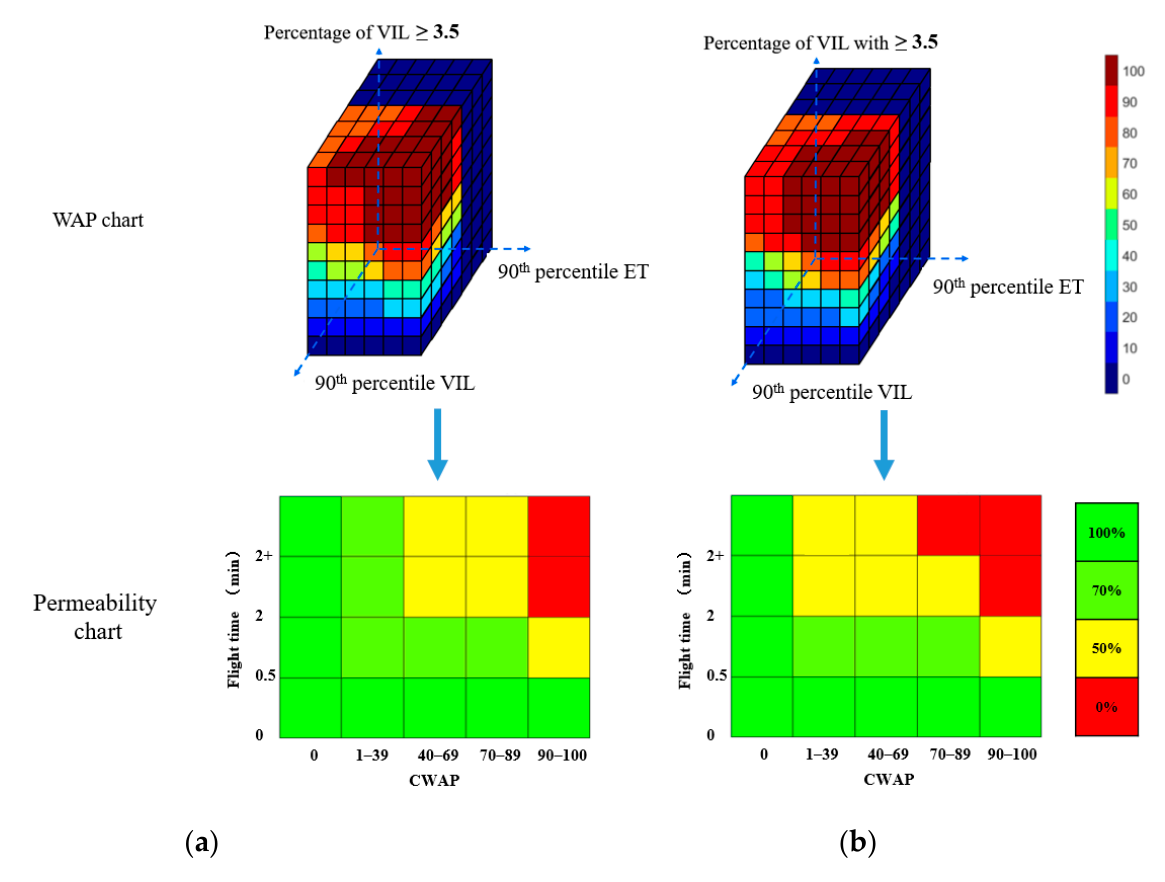
Figure 8. CWAP and permeability charts of the Guangzhou terminal area and Wuhan terminal area. ( a ) Guangzhou terminal area ( b ) Wuhan terminal area.